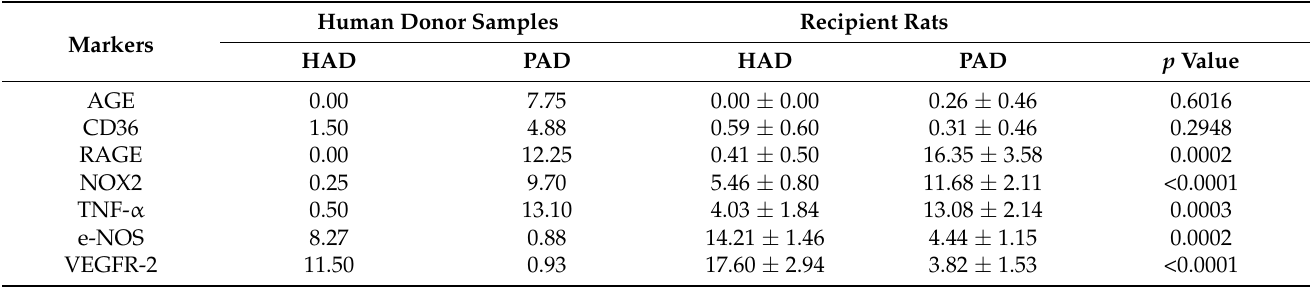
Table 4. Immunoreaction score (IRS) calculated for human arterial specimens and rats’ granulation tissue treated with human arteries-derived